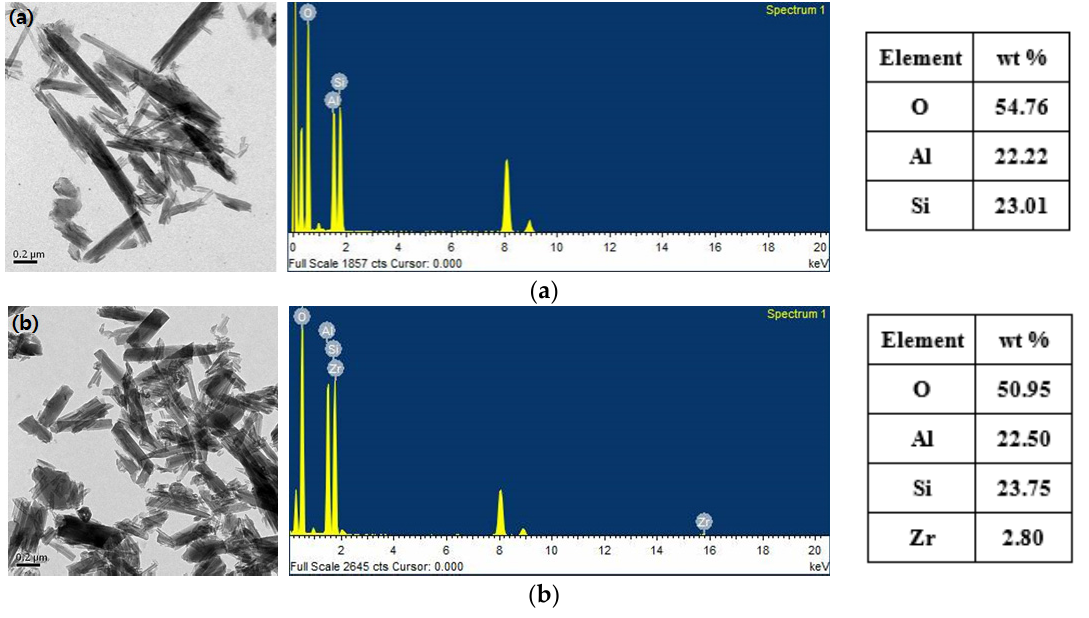
Figure 3. TEM images of ( a ) HNT and ( b ) Zr/HNT with the corresponding EDS elemental analysis shown in the middle and the element composition on the right.